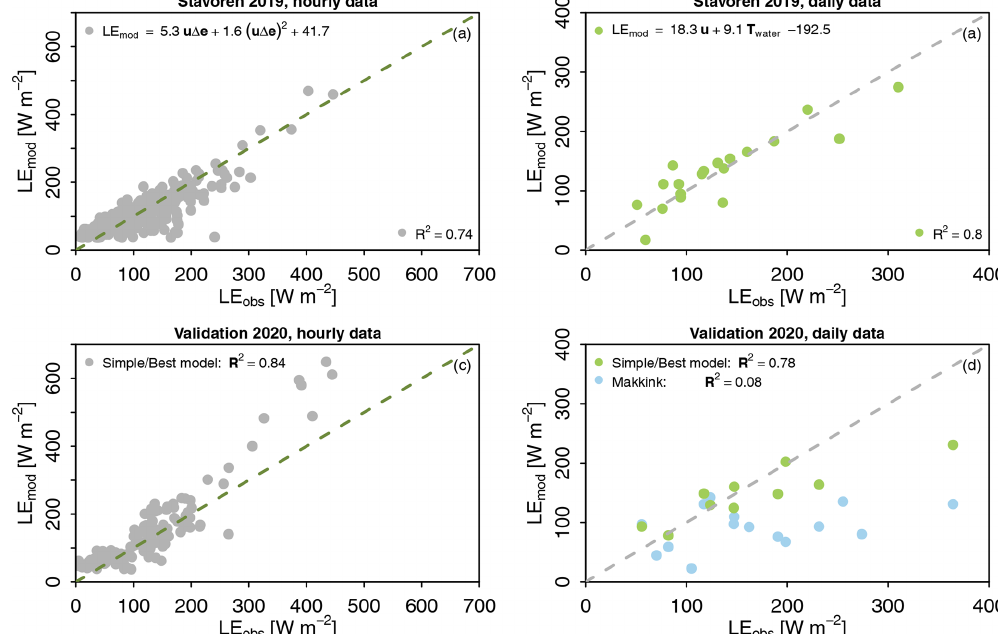
Figure 6. Evaluation of the developed “simple” and “best” data-driven models based on our own observations during the summer of 2019 (cal- ibration) and 2020 (validation) to estimate open water evaporation in Stavoren at hourly (a) and daily (b) timescales. The model equations are shown in panels (a) and (b) and differ from the models found based on routinely measured observations (see Table 2a). The results of the validation of the models are presented in panels (c) and (d) for hourly and daily timescales respectively. The simple model was also found to be the best model. The results of estimated evaporation using Makkink’s model (light blue) are added to the validation plots as a reference. Model performance is indicated by the values of the coefficient of determination ( R 2 ) shown in each